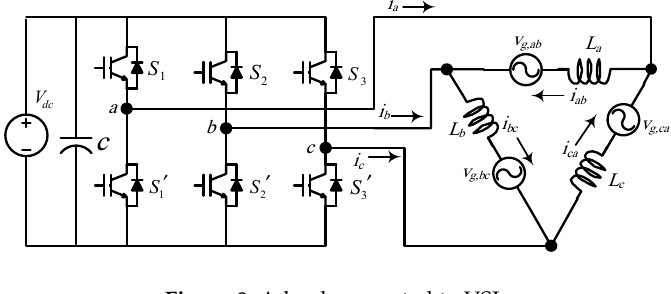
Figure 9. Δ -load connected to VSI.. Figure 9. ∆ -load connected to